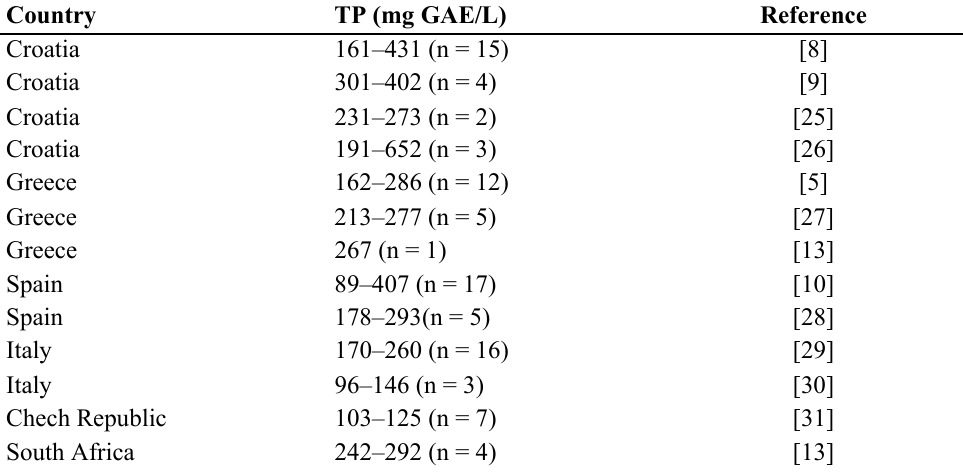
Table 2. Published values of phenolic content in different white